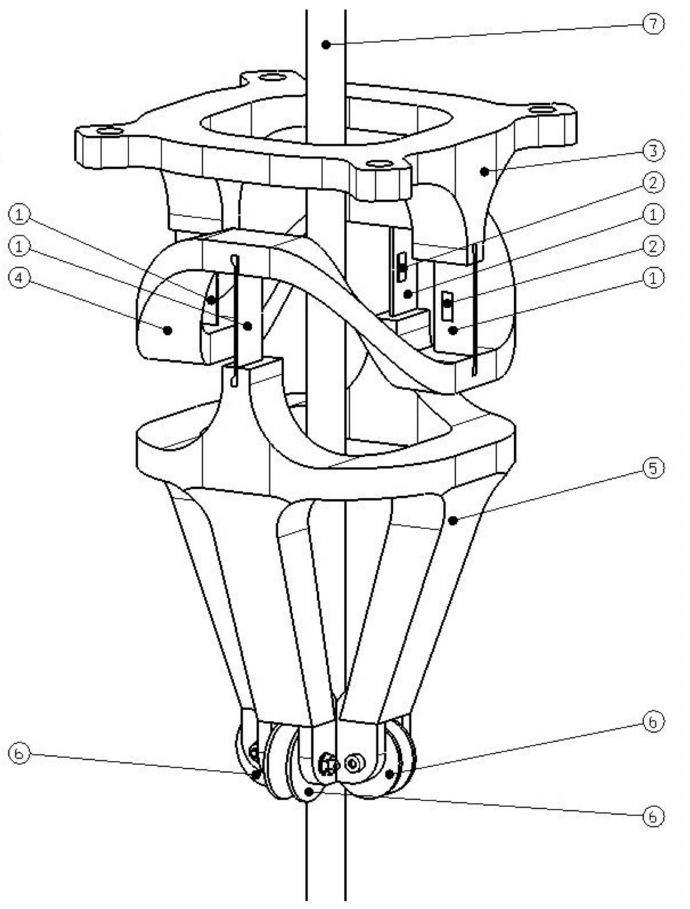
Figure 1. Payload swing angle sensor [7]. (1.) Flexible elements. (2.) Strain gauges. (3.) Device holder mounted on the crane trolley. (4.) An intermediate member performing a spherical motion. (5.) The part of the device performing the movement according to the rope. (6.) Pulleys touching the rope. (7.) Crane